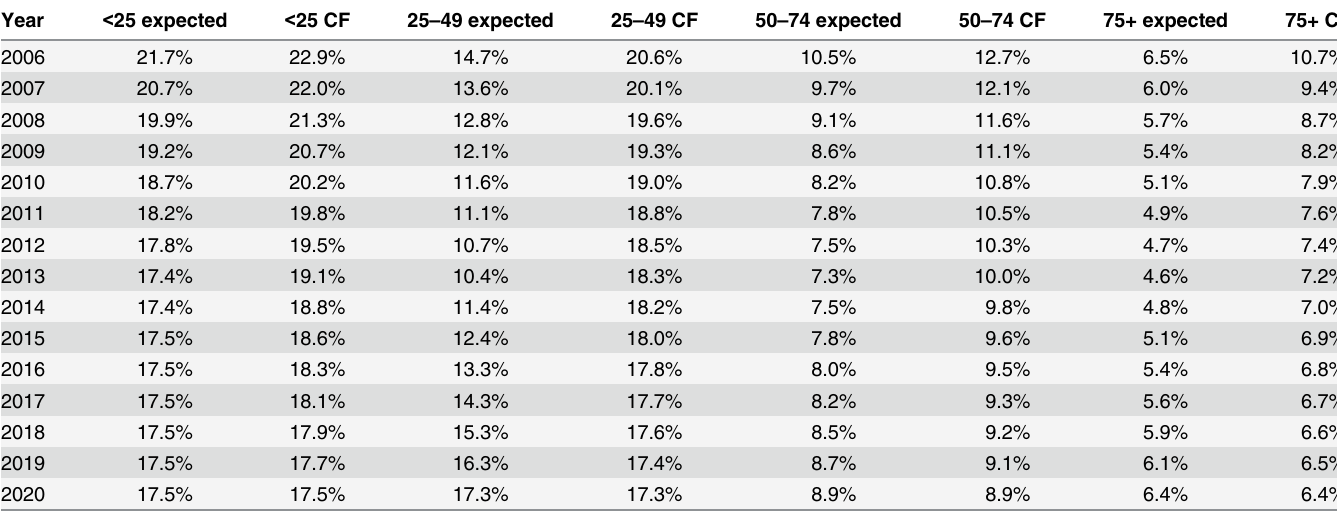
Table 1. Expected and counterfactual sunburn rates by cohort, 2006 – 2020.